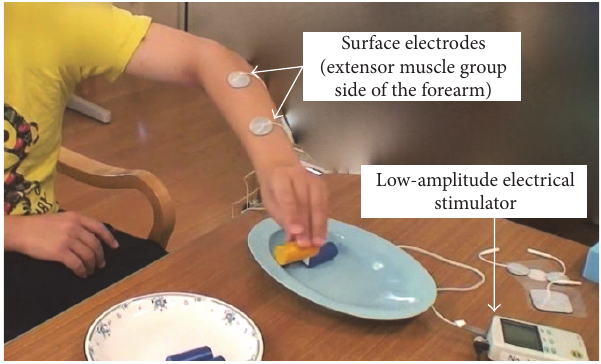
Figure 4: Effect of continuous electrical stimulation on the patient’s ability to carry 5 pegs. The electrodes were attached to the extensor side of the forearm. The patient was instructed to carry each peg from one dish to another dish. The length of time required to carry the 5 pegs improved from 19.4 s without continuous electrical stimulation to 14.5 s with continuous electrical